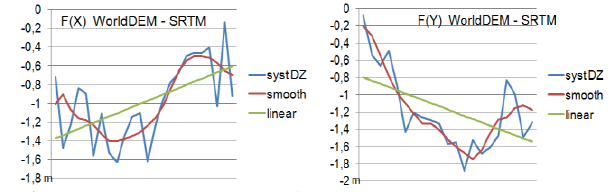
Fig. 17: Systematic errors of WorldDEM against SRTM as function of X (left) and Y (right) for whole area